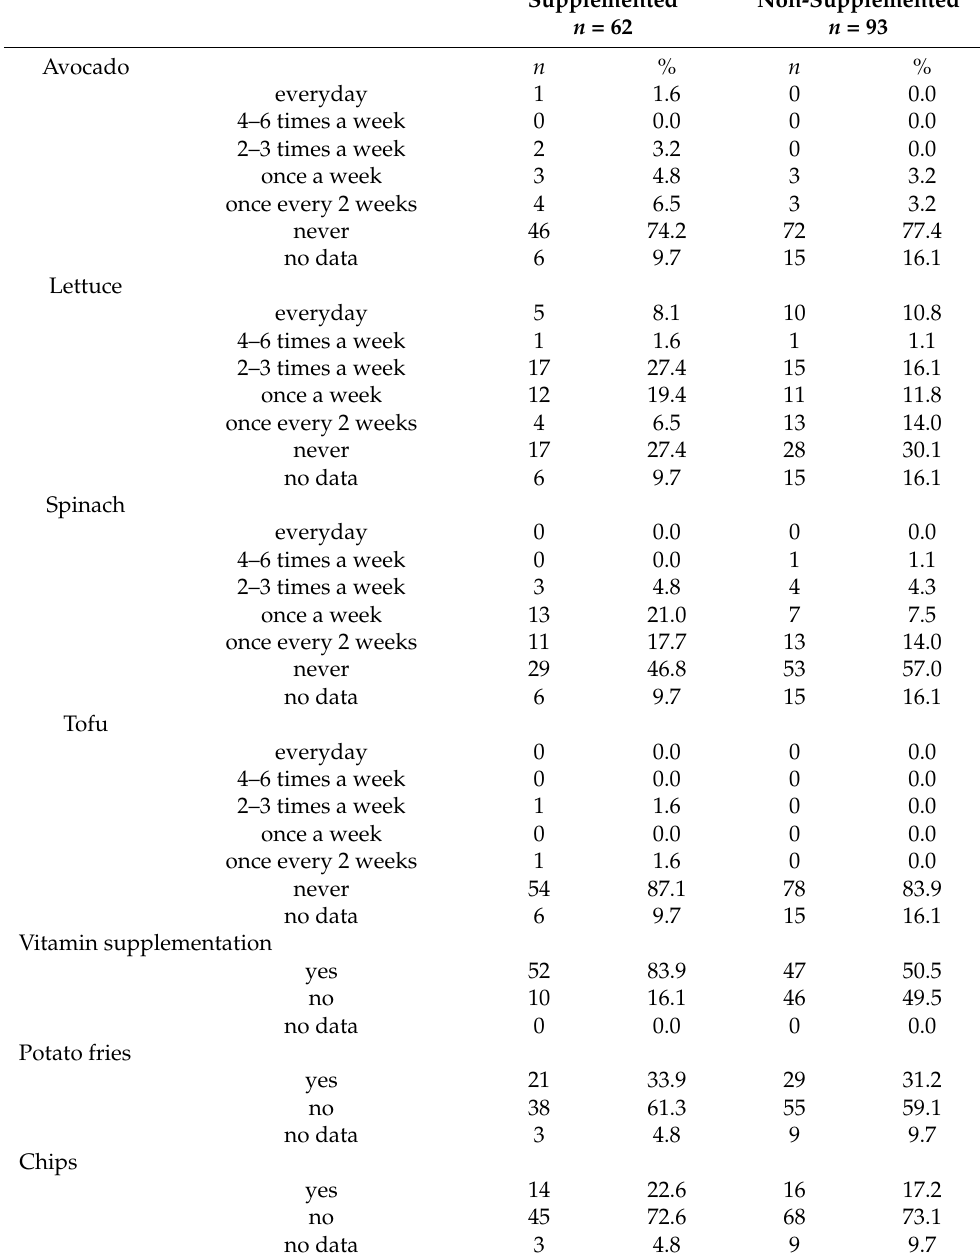
Table A7. Selected vegetables, fruits, tofu, and diet supplementation among investigated